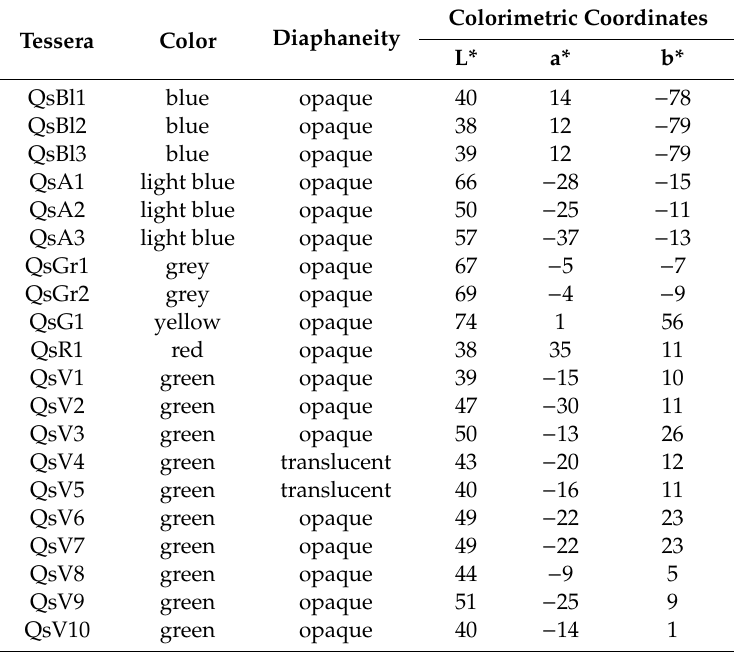
QsV6 green opaque − 22 23 QsV7 green opaque QsV8 QsV9 green opaque QsV10 green opaque